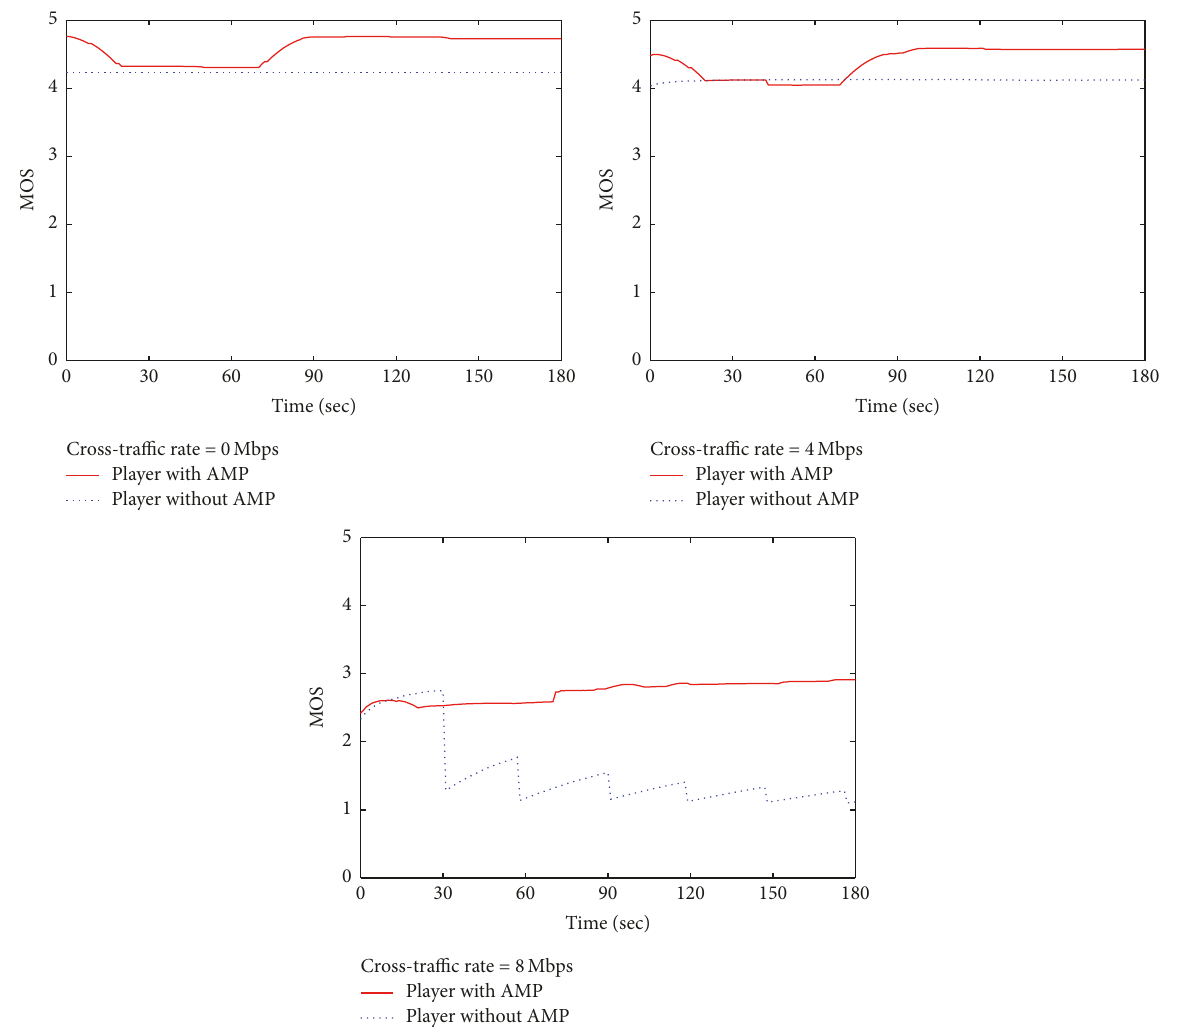
Figure 10: Comparison of synthetic MOSs/QoEs between the systems with and without AMP under various cross-traffic rates.